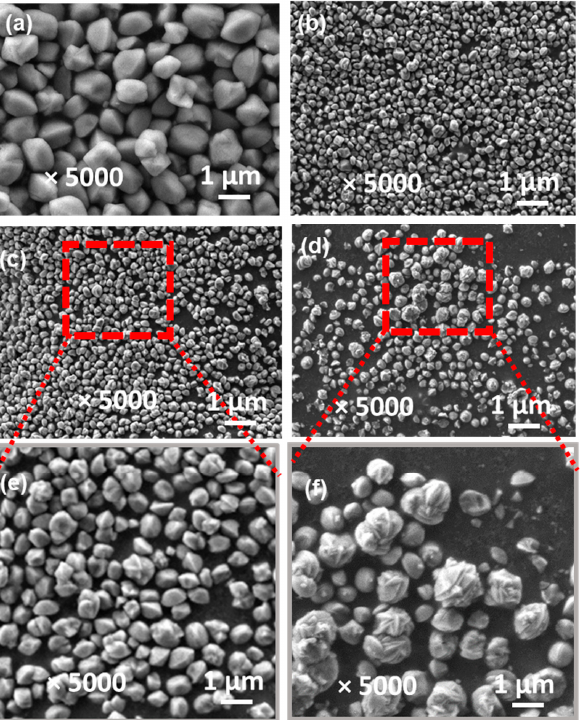
Figure 1. SEM images of SNCM precursor for ( a ) pH value of 2 (with a fixed co-precipitation time of 3 h), ( b ) co-precipitation time of 180 min (with a fixed pH of 2), ( c ) the co-precipitation time of 3 min with vigorous agitation, ( d ) the co-precipitation time of 3 min without vigorous agitation, and ( e , f ) enlarged portion of the co-precipitation time of 3 min with/without vigorous agitation.